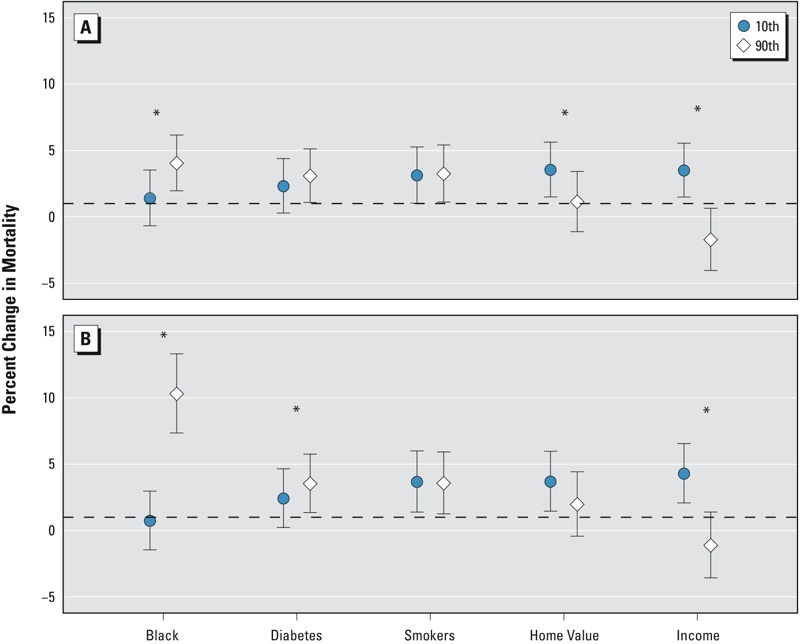
Percent change in mortality with 95% confidence intervals for each interquartile range (2.0 μg/m3) increase in PM2.5 at the upper and lower decile of each modifier: percent of black residents (10th percentile = 0.2%, 90th percentile = 52.0%), percent of persons with diabetes (10th percentile = 6.1%, 90th percentile = 9.2%), smoking rate (10th percentile = 7.8%, 90th percentile = 15.9%), median home value (10th percentile = 189,300, 90th percentile = 578,600 USD), and median household income (10th percentile = 35,625, 90th percentile = 115,049 USD) among (A) the whole population and (B) the white residents in New Jersey. Census tract–specific percent of black residents, median home value, and median household income came from Census 2000 data (U.S. Census Bureau 2000). County-level percent diabetics and smoking rate came from BRFSS data from 2004 to 2009 (CDC 2013).
*Indicates interaction p < 0.05.